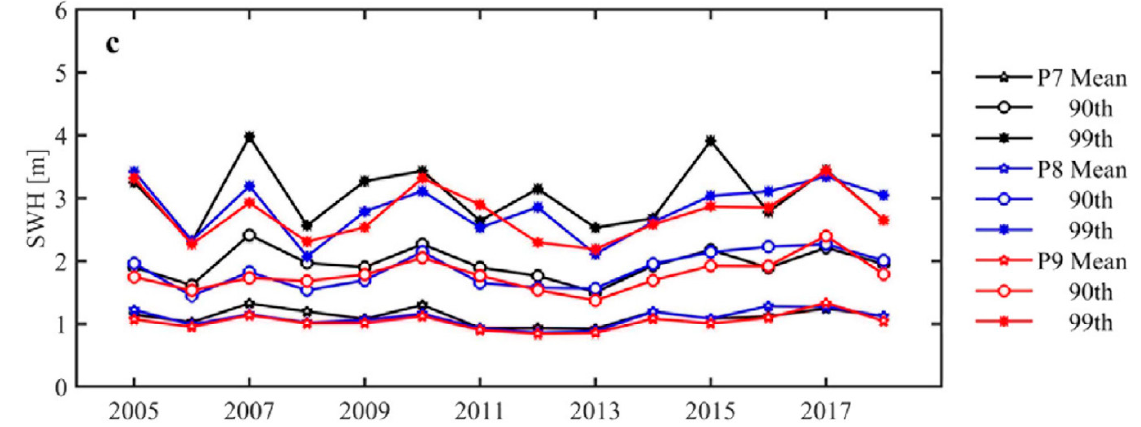
Figure 16. Interannual variations of mean and extreme SWH in the Kara Sea (Duan et al., 2019).